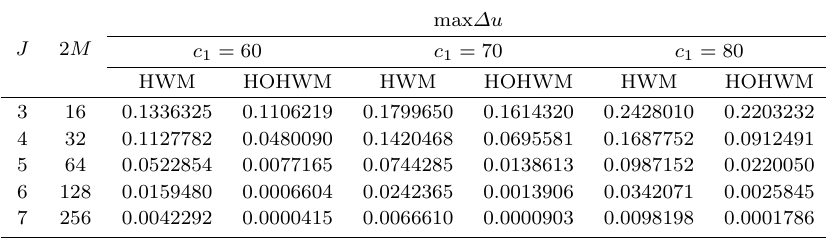
Table 1. Results for the wave equation: maximal deviation of the numerical solution from the exact solution max ∆u against the resolution parameter J with initial conditions (5.1) and boundary conditions (4.5) ( c = 1 / 2, x 0 = 1 / 4, x ∈ [0 , 1], t ∈ [0 , 1], c 1 = 60 , 70 , 80). max ∆u J 2 M c 1 = 60 c 1 = 70